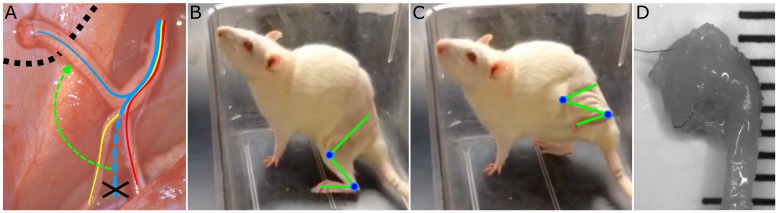
The modified tibial neuroma transposition (TNT) surgery and RF EMF behavioral response assays.(A) Depiction of the TNT surgery. The three distal branches of the sciatic nerve (tibial: blue, sural: red, and common peroneal: yellow) were teased from the surrounding connective tissue and from each other. The tibial branch was then transected (black X) and transposed from its original (dashed blue line) to its final orientation (solid blue line), and sutured to the fascia adjacent to the hip bone (black dashed line). TNT surgery resulted in neuroma formation. (B) 8 week old neuroma bulb. Separation between black lines equals 1 mm. (C) Representative image of a Wistar rat during (C) baseline and (D) stimulus period (10 minutes at 756 ± 8.5 mW/mm2) of the RF EMF (915 MHz) behavioral assay. Animal presents a left hind limb withdrawal. This action represents a response score of 1. (E) Timeline for surgical procedures (S1 and S2) and behavioral response assays.